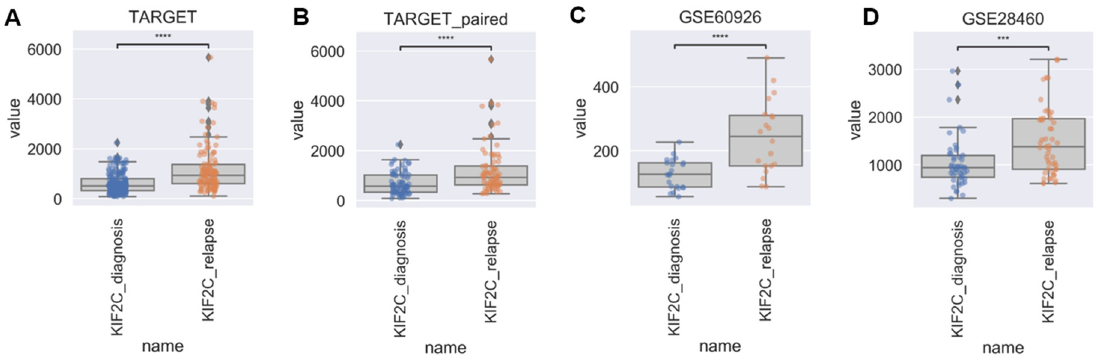
Figure 1. Differences in expression levels of KIF2C . Comparison of KIF2C expression levels in ( A ) TARGET, ( B ) TARGET_paired, ( C ) GSE60926, and ( D ) GSE28460 (**** indicates significance at p value < 0.0001, *** indicates significance at p value <0.001).